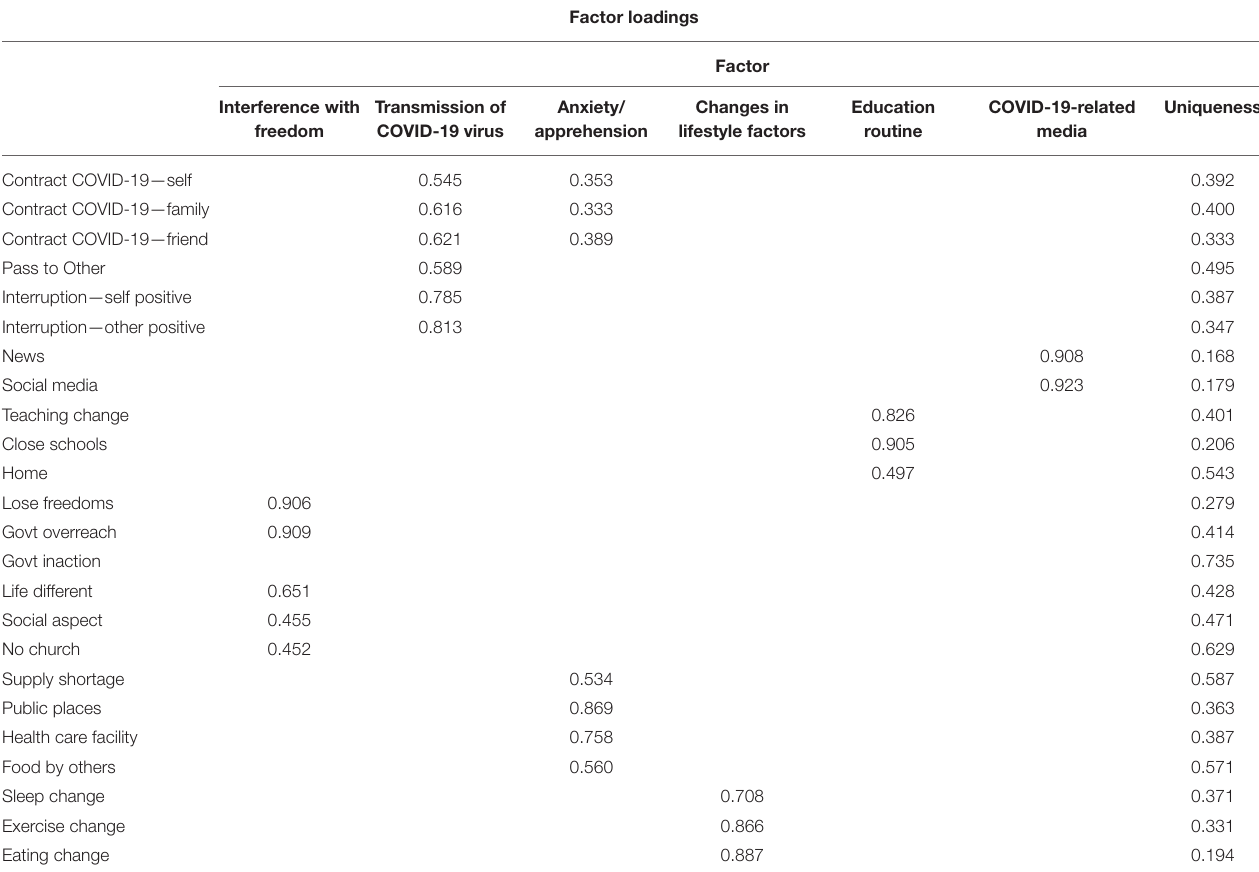
TABLE 4 | Summary of exploratory factor analysis results pertaining to the items addressing COVID-19-related sources of stress, using the principal axis factoring extraction method in combination with a promax rotation ( n =